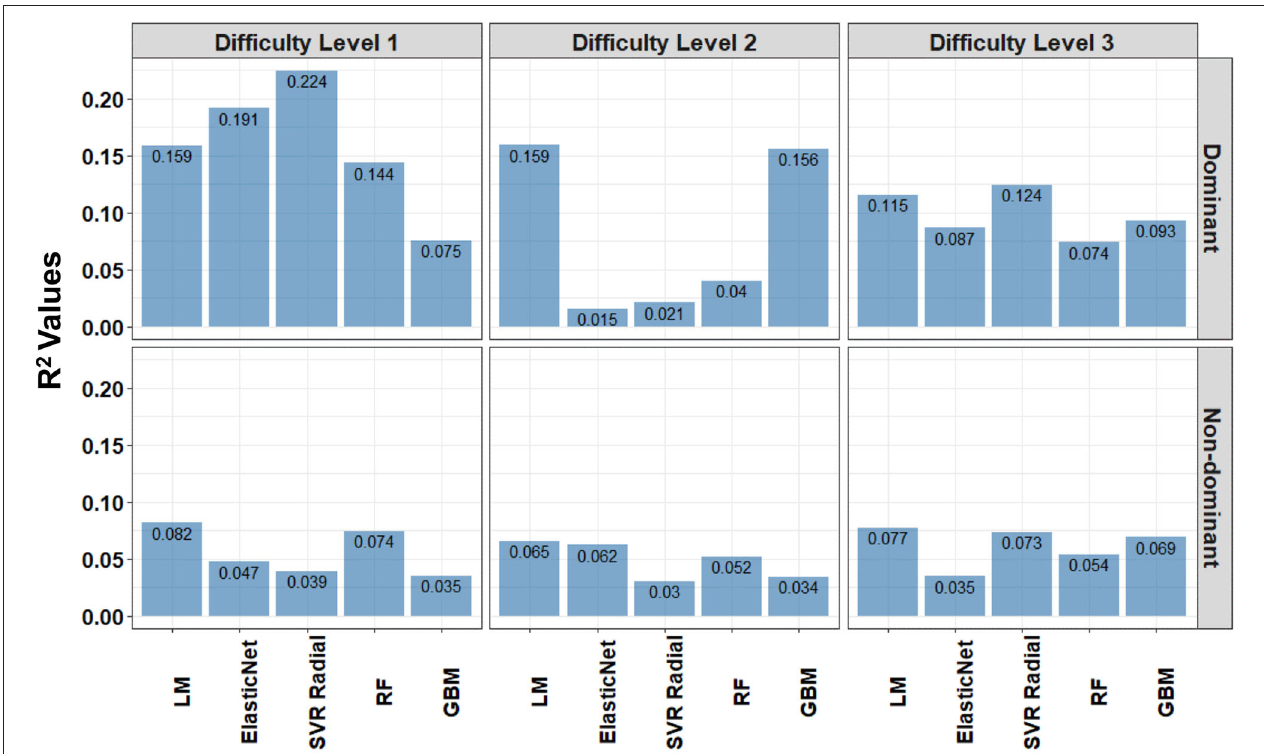
FIGURE 11 | The out-of-sample test performance (i.e., independent validation) of the predictive regression models when 9HPT average (in seconds) is the response variable and the sum of Hausdorff distances is the only explanatory variable in the linear regression model (LM). The explanatory variables in the Elastic Net (ElasticNet), Support Vector Regression with Radial Basis Function kernel (SVR Radial), Random Forest (RF), and Stochastic Gradient Boosting (GBM) models are Kurtosis of Velocity, Kurtosis of Radial Velocity, Kurtosis of Angular Velocity, and the sum of Hausdorff distances. The test performance was measured using R 2 of model predictions per dominant and non-dominant hands among the patients with MS at the difficulty level 1, 2, and